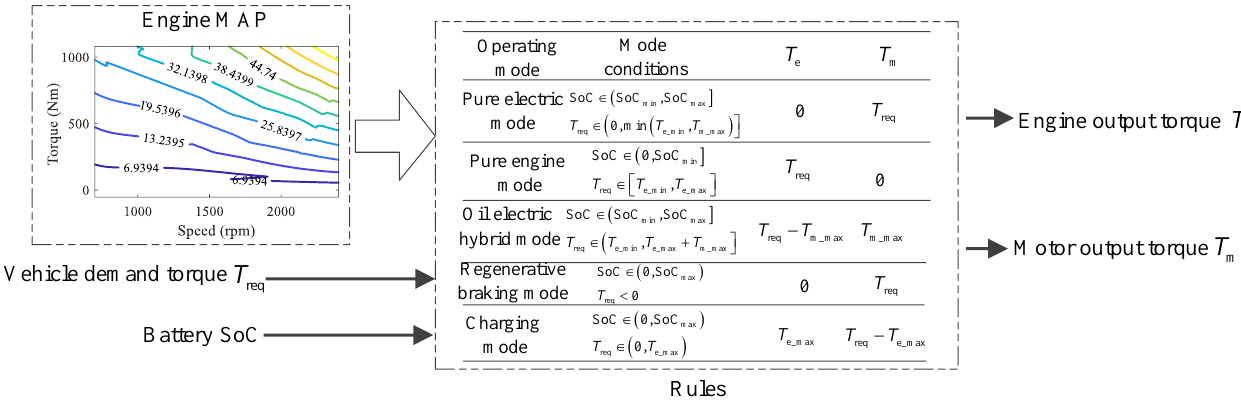
Figure 10. The design principle of deterministic RB EMSs [22,34]. T is the total demand torque of the hydraulic system and r e q S o C represent the minimum and maximum values of S o C and drive assembly; m a x m i n T show the upper and lower boundaries of the engine T and SoC, respectively; e_min e _ m a x T and T indicate the upper and lower output torque; respectively; and m _ m a x m _ m i n